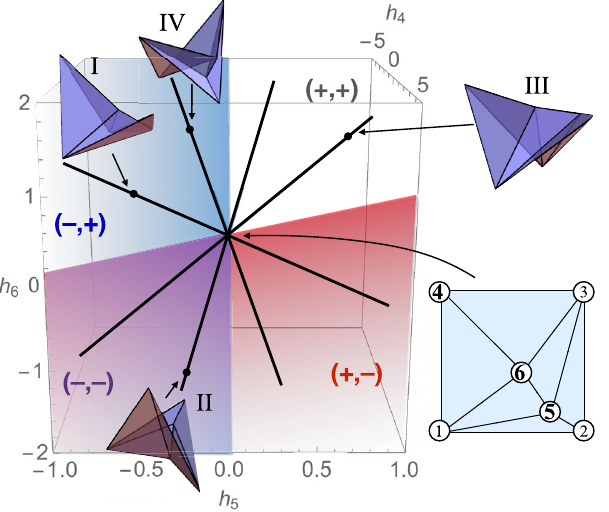
FIG. 8. (a) Crease pattern of a triangulated square with V with a pair of branches where the MV assignments to the edges are identical. Edges colored red and blue represent mountain and valley folds, respectively. Vertices with red and blue outlines represent vertices that are popped up and popped down in both branches, respectively. The state of the green vertex (labeled 7) distinguishes the two branches; i.e., it is popped up in one branch and popped down in the other. (b),(c) Images of folded configu- rations on the two branches. Movies 5 and 6 in Supplemental Material [23] show animations of the folding motions along these branches from the unfolded